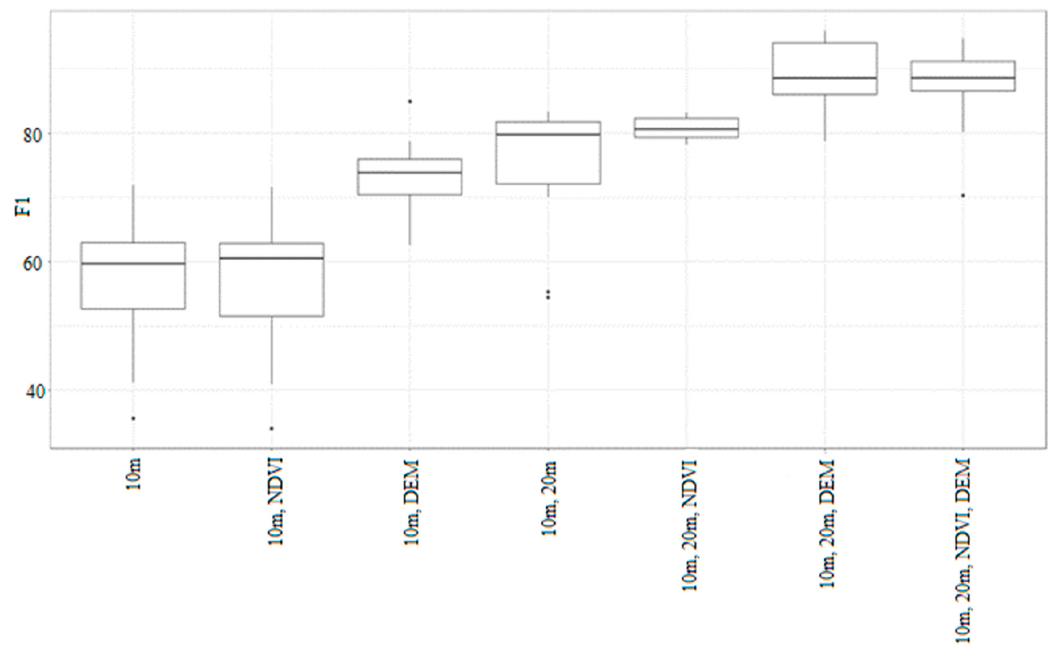
Figure 6. The F1 value for the forest type classification based on the combination of different variables.